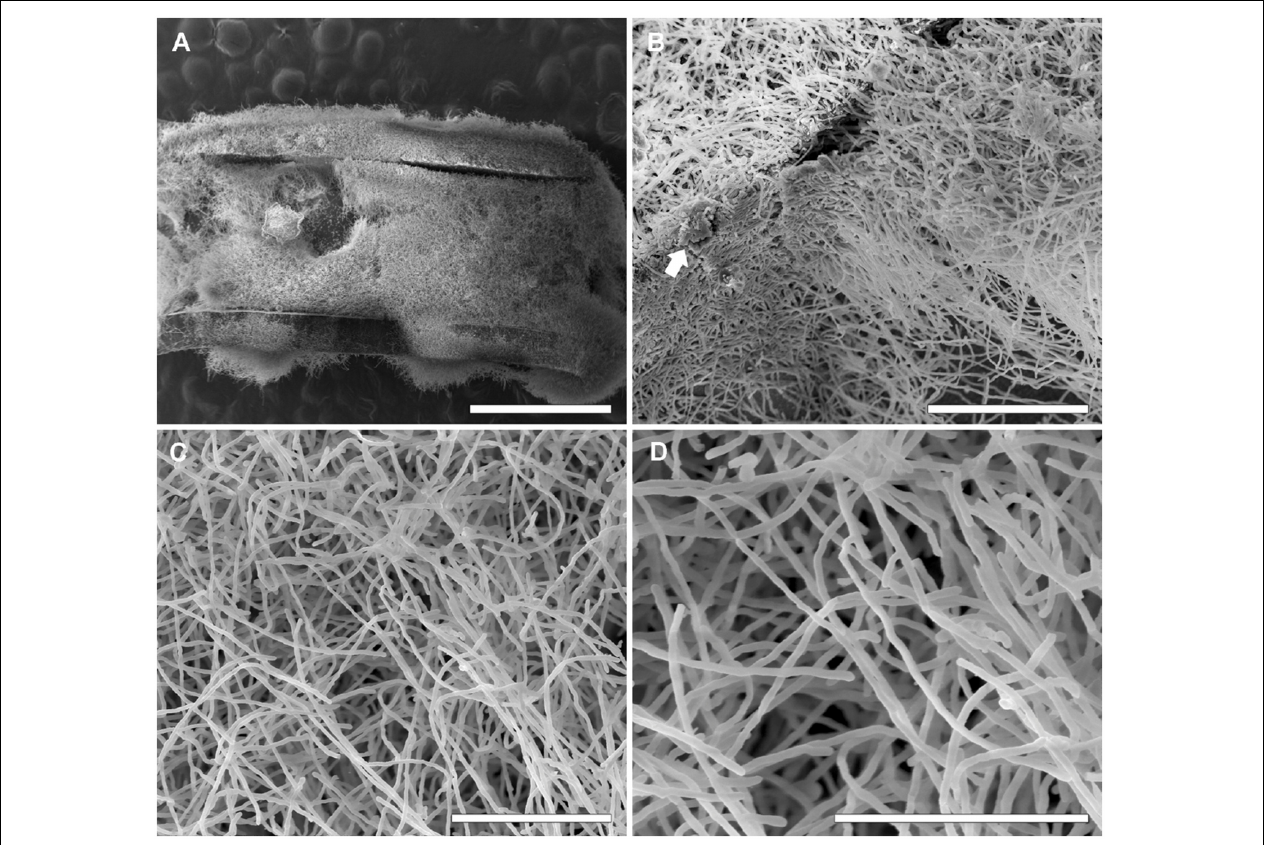
FIGURE 6 | Scanning electron microscopy of S. aurantiacum clinical isolate (CBS 136046) biofilms grown on CVCs. Biofilms were grown in vitro on the inner surface of 0.5 cm sections of sterile CVCs for 24 h. (A) A dense mass of S. aurantiacum biofilms covered the entire CVC surface. (B,C) A representative area of an internal area of a biofilm with a dense network of hyphae (white arrow). (D) A higher magnification of the central area shown in panel (C) . The bars correspond to 1 mm (A) , 100 µ M (B) , 50 µ M (C) , and 40 µ M (D) .